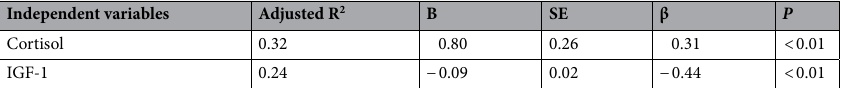
Table 3. Stepwise multiple regression analysis of the relationship between the Brief Psychiatric Rating Scale scores and independent variables. IGF-1 insulin-like growth factor 1, B non-standardized regression coefficient B, SE standard error, β standardized regression coefficient